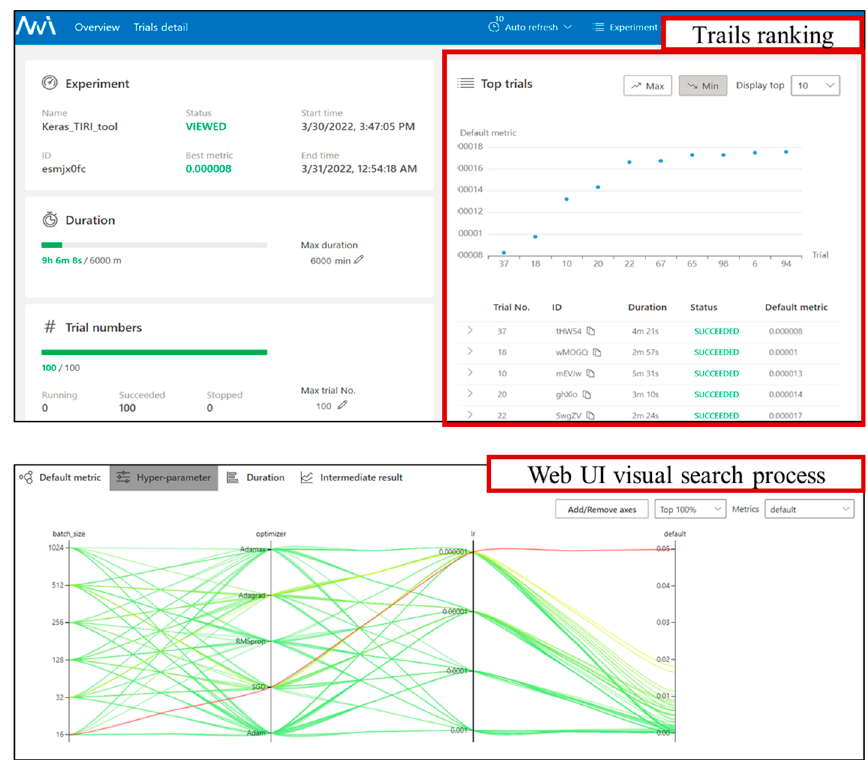
Figure 7. NNI WebUI board.